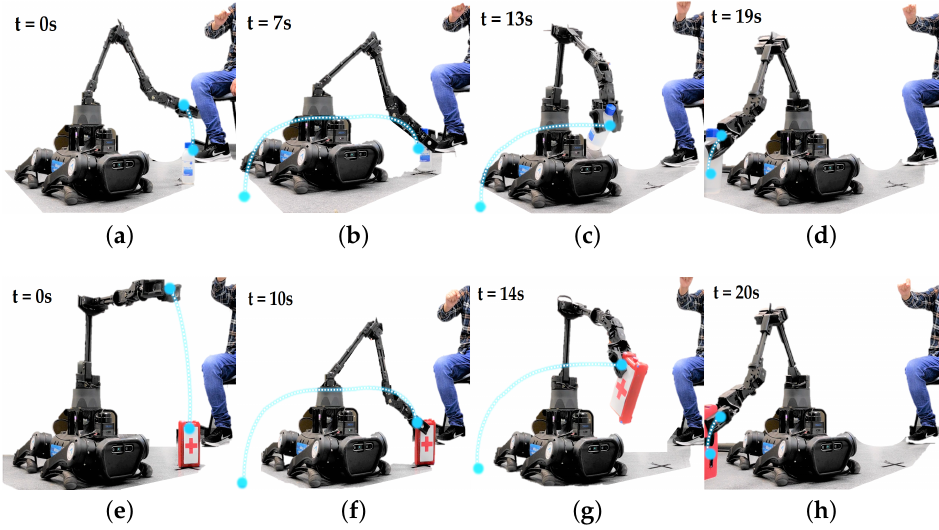
Figure 6. Manipulation tests for transporting objects (First kit aid ( a – d ) and Alcohol ( e – h )), through MR Tele-operation. ( a ) Approaching the manipulator end-effector to the object. ( b ) Close the griper and capture the object. ( c ) Object transportation to the destination point. ( d ) Gripper opening to deposit the object. ( e ) Robotic arm in the home position, the destination point is in blue. ( f ) Close the griper and capture the object. ( g ) Object transportation to the destination point. ( h ) Gripper opening to deposit the